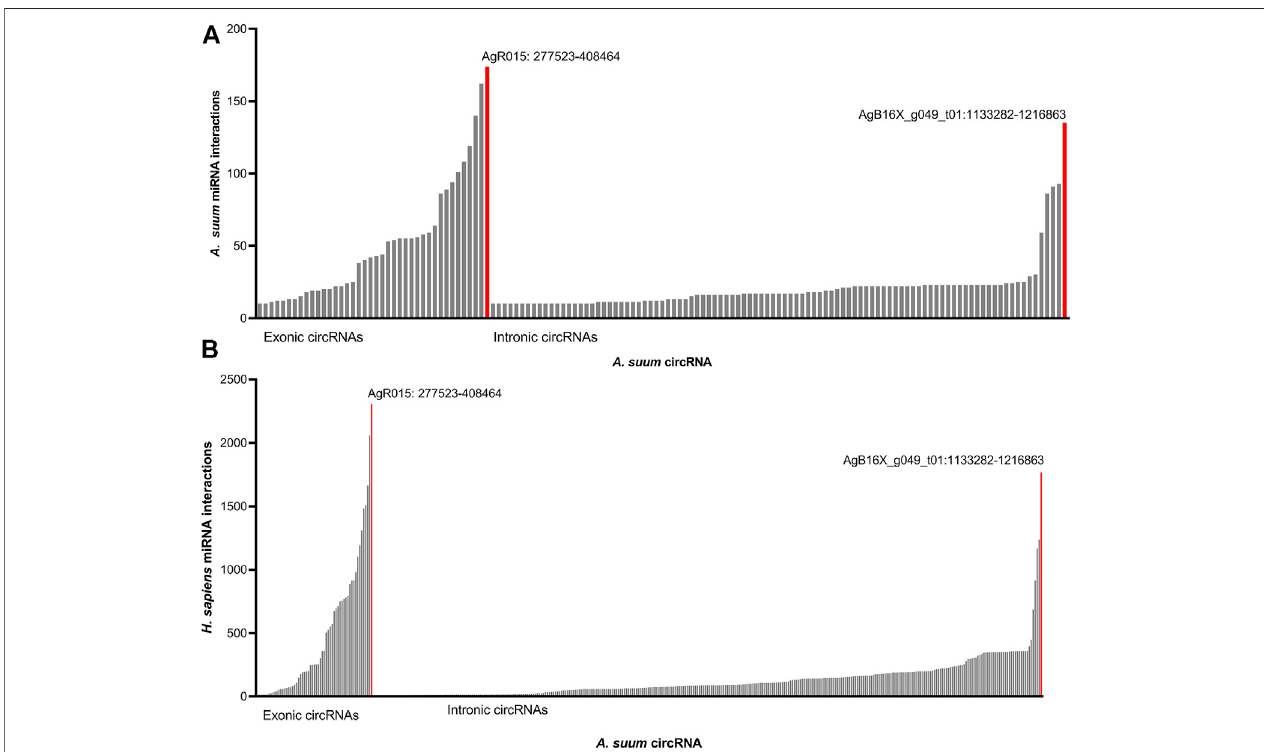
FIGURE 7 | Ascaris suum circRNAs interact with both endogenous and host miRNAs. miRanda was used to predict interactions between A. suum circRNAs and both endogenous A. suum miRNAs as well as host (human) miRNAs. (A) Predicted interactions between A. suum circRNAs and A. suum miRNAs. The number of interactions per circRNA are shown and circRNAs with under 10 miRNA interactions were excluded from these graphs. Exonic circRNAs typically had a more miRNA interactionspercircRNAthanintroniccircRNA. (B) Predictedinteractionsbetween A.suum circRNAsandhumanmiRNAs.ThenumberofinteractionspercircRNA are shown and circRNAs with under 10 miRNA interactions were excluded from these graphs. Again, exonic circRNAs typically had a more miRNA interactions per circRNA than intronic circRNAs.